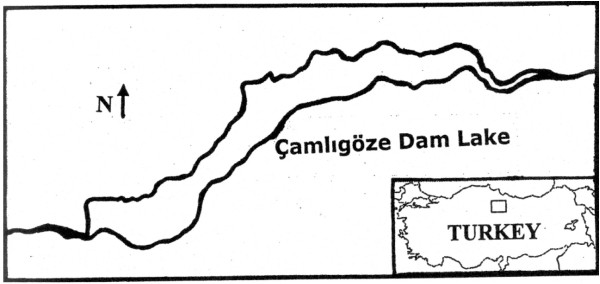
Çamlıgöze Dam Lake.